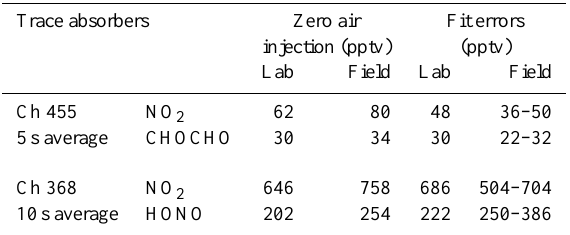
Table 3. Detection limit (2 σ) estimation from two different meth- ods: (1) standard deviation of gas concentrations retrieved in zero air and (2) fit errors from DOASIS. For the laboratory data, 1h of zero air measurements in the lab were analyzed. For the field data, multiple cycles of zero air measurements acquired during CARE Beijing-NCP 2014 were